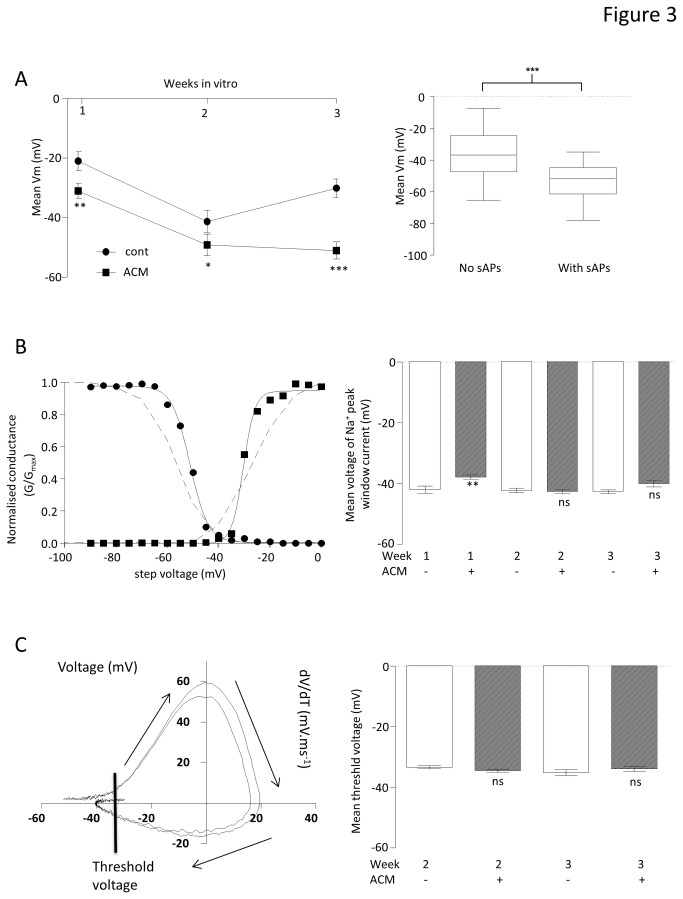
Effect of ACM on basic biophysical properties of iPSC-derived neruons .A. Comparison of mean resting membrane potentials (Vm) of neurons differentiated in control medium (cont, circles) or ACM (squares) for up to 3 weeks. T-tests were performed at each week to compare control medium- and ACM-treated cells. *P < 0.05, **P < 0.01, ***P < 0.001,nsnot significant; n = 147 (left). Box and whisker plots comparing all cells which either did, or did not, demonstrate spontaneous activity plotted against Vm. Horizontal bar is the mean, box shows the 95% confidence and whiskers show upper and lower quartiles. T-test was performed to compare the two means. ***P < 0.001; n = 298 (right).B. Exemplar, normalized conductance (G/Gmax) vs. voltage plots (adjusted for series resistance and junction potential). Squares represent activation (and circles represent inactivation of Na+ channels. Sigmoid Boltzmann curves was fitted to both data sets (R2 > 0.99 for both), which intersected at the voltage at which the voltage at which the hypothetical peak Na+ current occured. The dashed lines are re-presentations of data from [36]showing voltage activation and inactivation curves for NaV1.2 (left). Bar graphs comparing mean voltages at which the peak Na+ window current occurs for cells differentiated in control medium and ACM for up to 3 weeks. T-tests were as in A, above. **P < 0.01,nsnot significant; n = 77 (right).C. Rate of change in voltage (dV/dT) vs. voltage orbital plots from 2 exemplar iAPs Arrows indicate the direction of time. Line indicates voltage threshold (left). Bar graph showing the mean voltage thresholds for iAPs in ACM and control at weeks 2 and 3. T-tests were performed to compare control medium and ACM-treated cells. n
snot significant; n = 29 (right).